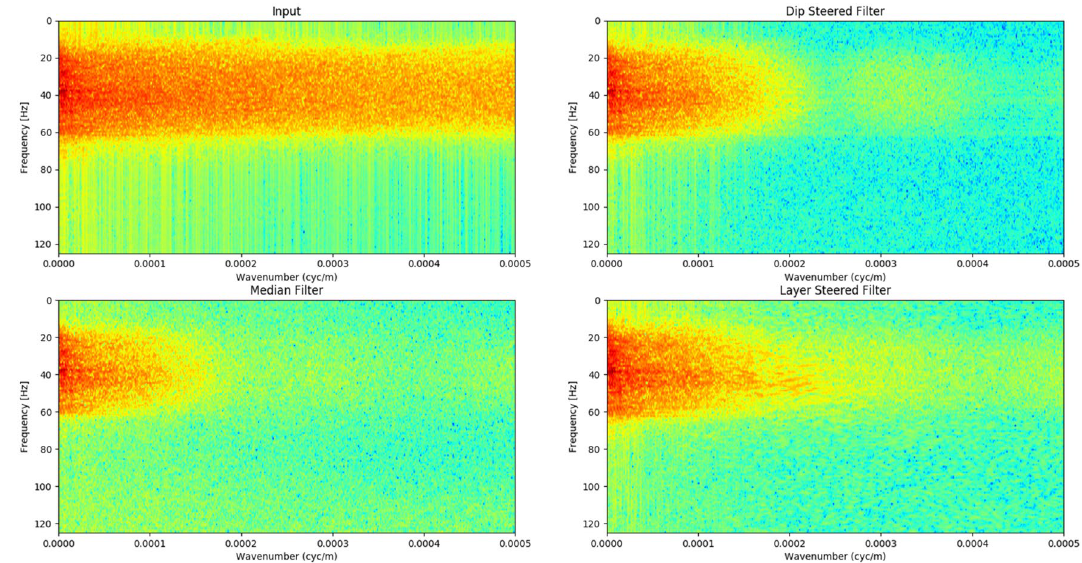
Fig. 6 Representation of FK domain of input data, median filter, dip-steered filter, and layer-steered filter for seismic data shown in Fig.